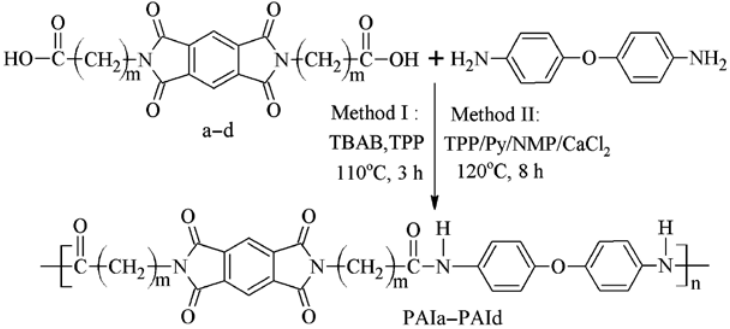
Figure 3: Synthesis of PAIs by two methods (PAIa – PAId). PAIa: m = 1; PAIb: m = 2; PAIc: m = 3; PAId: m = 5.